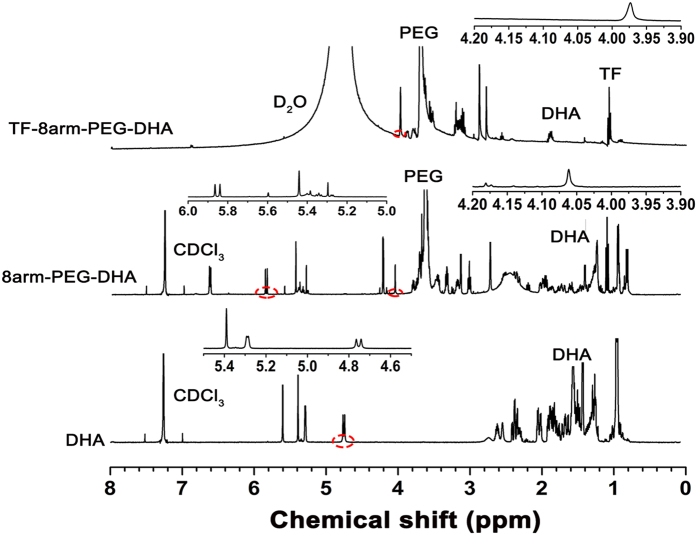
1H-NMR spectra of DHA in CDCl3 (a), 8arm-PEG–DHA in CDCl3 (b), TF-8arm-PEG–DHA in D2O (c).